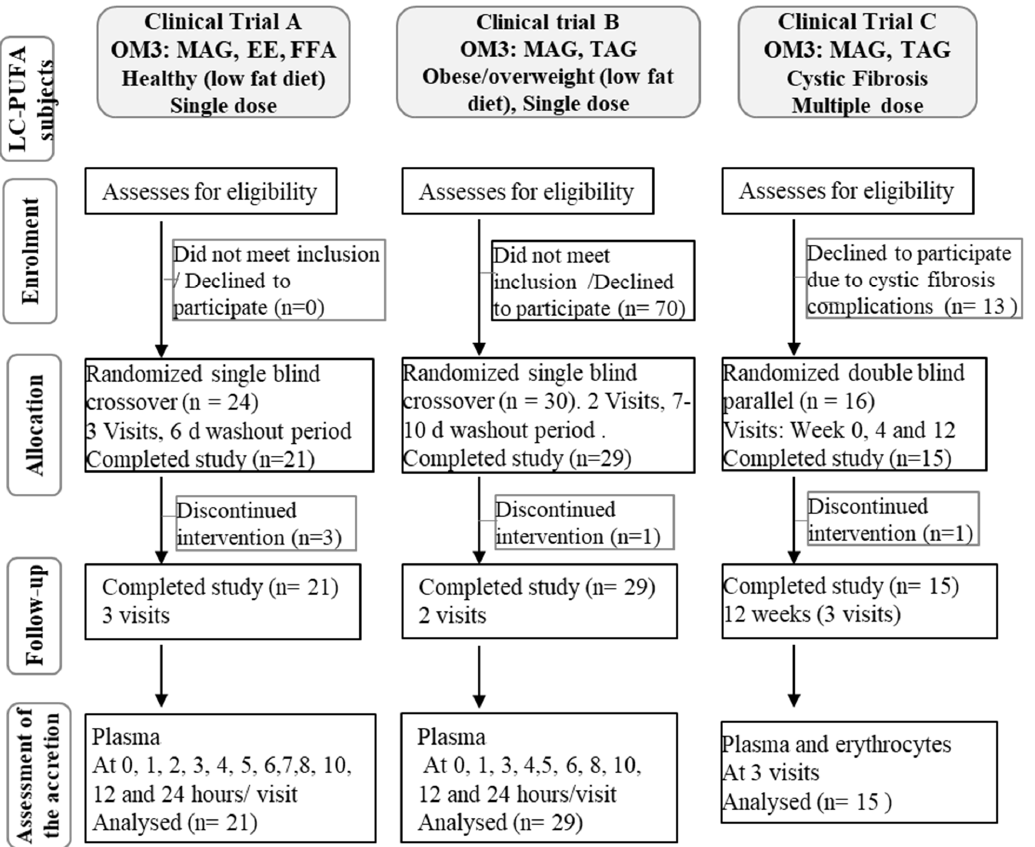
Figure 3. Flow diagram for study participation in clinical trials.